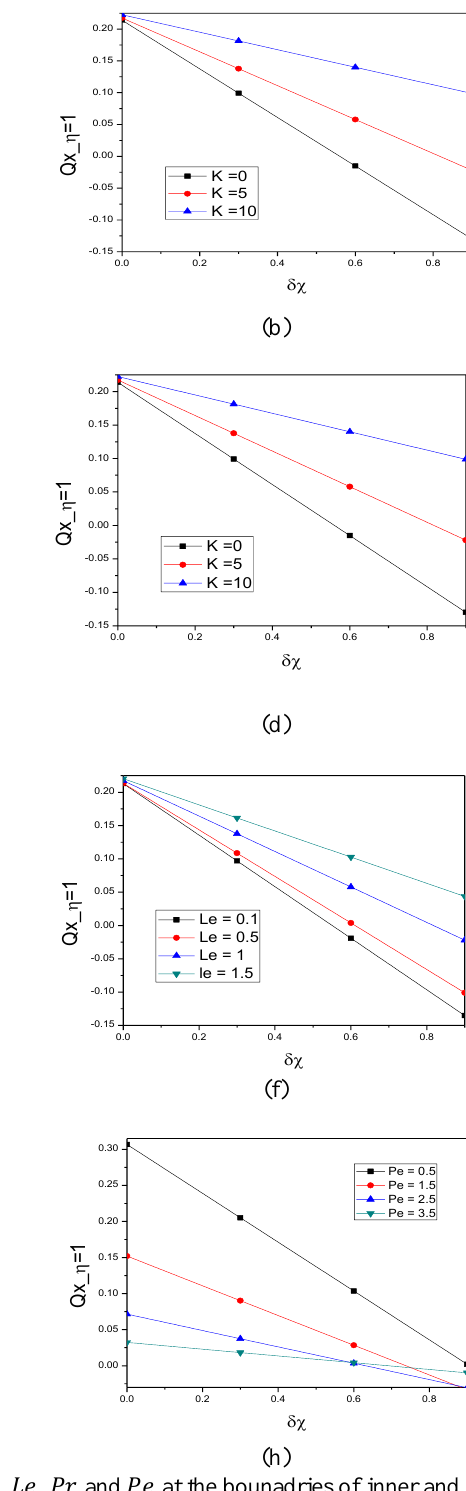
Figure 4. Profiles of profiles of 𝑄